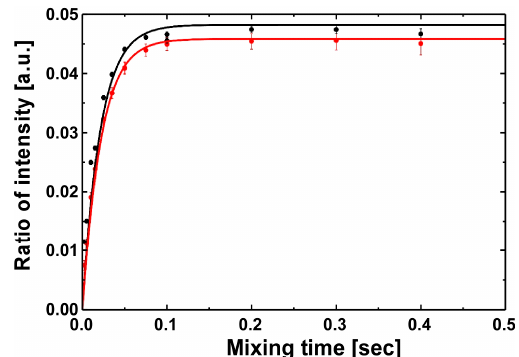
Figure 3. Comparison of isomerase activity between the wild-type protein and the S138A mutant to phosphorylated peptide Cdc25C. The isomerization rate for the S138A mutant was determined by a series of EXSY spectra with the phosphor-peptide Cdc25C at varying exchange times (red). The previously reported data for the wild-type [13] were included for reference (black).